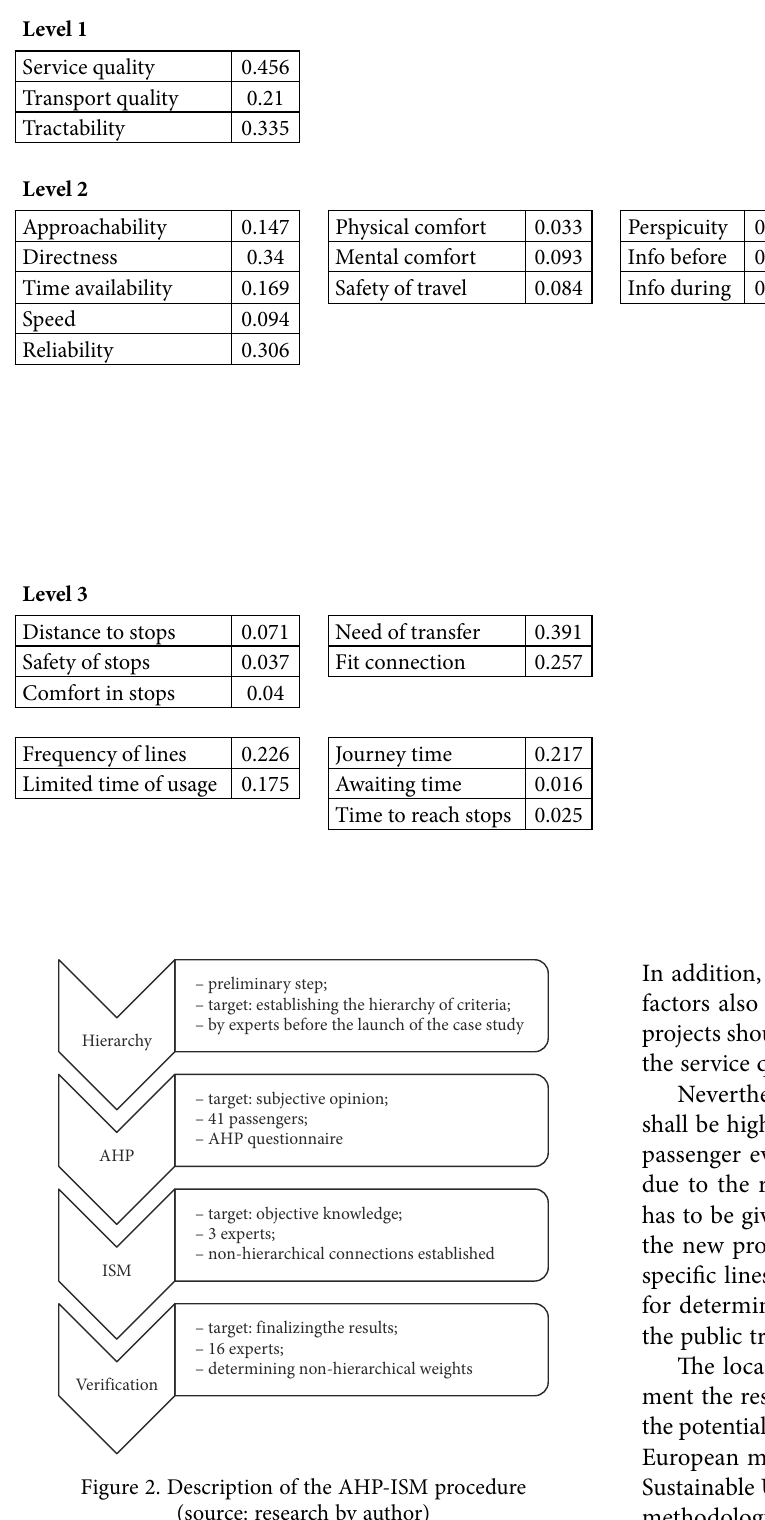
Table 4. The ultimate modified scores of the integrated approach AHP-ISM (source: research by author)